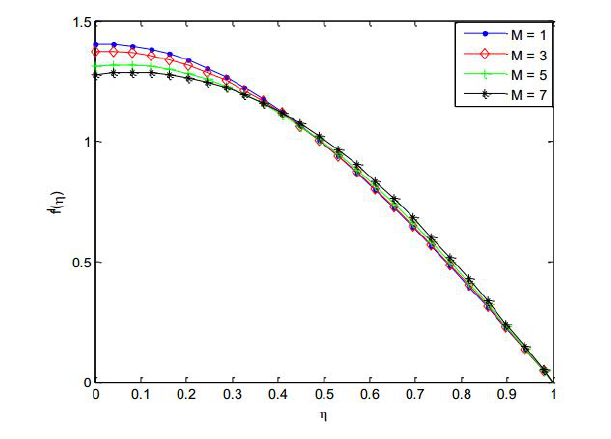
Figure 4. Effects of magnetic number on the velocity of the